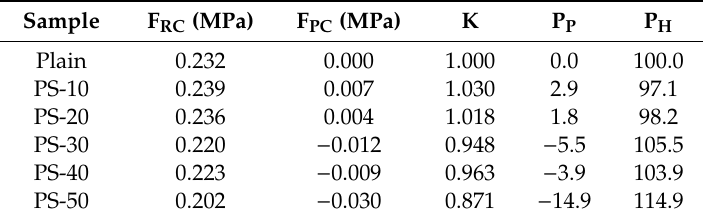
Figure 5. Compressive strength of cement mortars with phosphorus slag at di ff erent ages. Table 4. Integrate performance of the pozzolanic activity of phosphorus slag in cement mortars at 3 days.